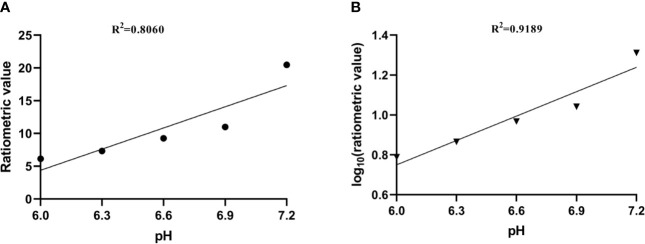

(A) CEST ratio was linearly related to pH. (B) The log10 ratio of the CEST effect was linearly correlated with the pH. CEST, chemical exchange saturation transfer.